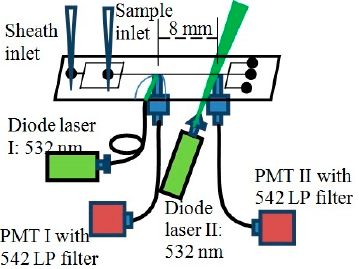
Figure 10. Schematic set-up for the measurement of the transit time of fluorescent particles in the microchannel.